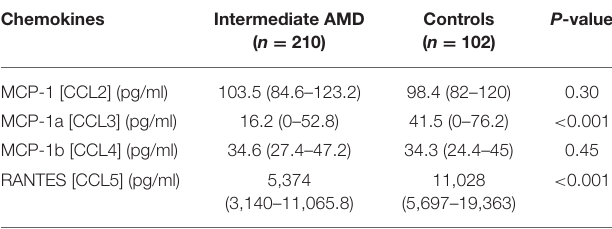
TABLE 2 | Chemokine levels for cases with intermediate AMD vs.